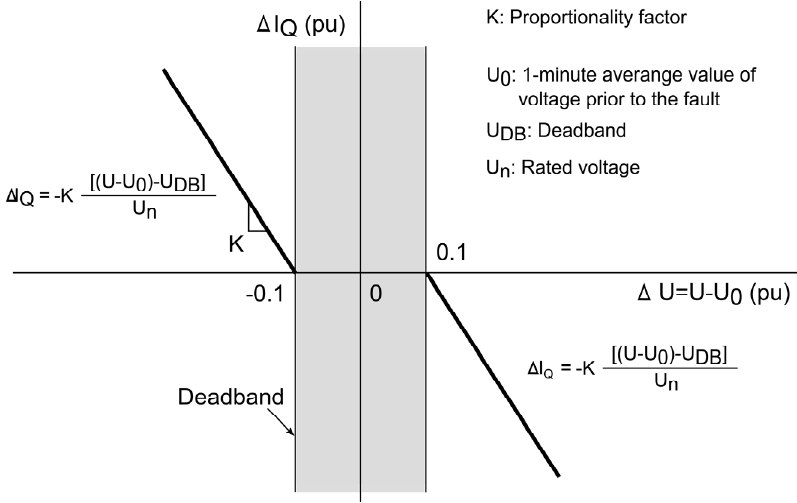
Figure 6. Additional current related to the reactive power characteristic.